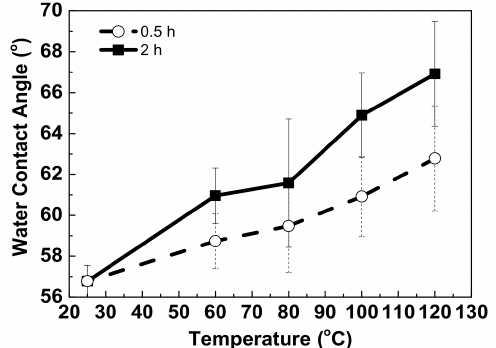
Figure 6. WCA versus temperature of hard baking after 2 h on UV-curable